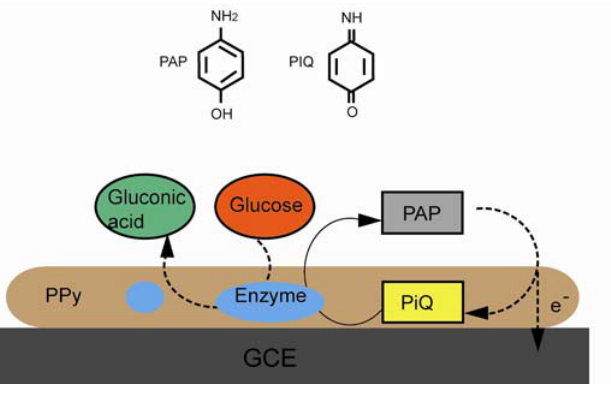
Figure 17. Enzyme was embedded in a PPy surface matrix coated on a GCE (adapted from